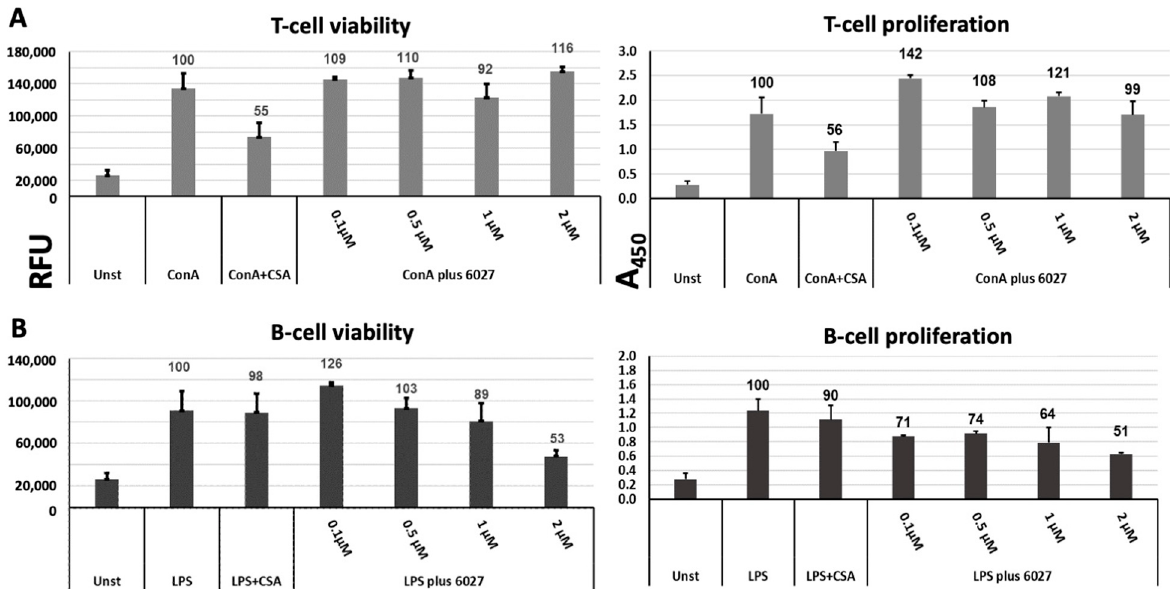
Figure 6. Effects of peptide 6027 on murine T cells ( A ) and B cells ( B ) with respect to viability and proliferation in vitro; 96-well plates were seeded with splenocytes obtained from murine spleen (2 × 10 6 cells/mL, 100 µL/well), and were exposed to ConA (5 µg/mL) or LPS (10 µg/mL). Peptide 6027 was added at 0.1, 0.5, 1 and 2 µM, respectively, and cultivation was carried out for 48 h at 37 °C/5% CO 2 . Viability was assessed by resazurin reduction and is given as relative fluorescence units (RFU); the proliferation of cells was measured by BrdU ELISA and is given as absorption at 450 nm (A 450)